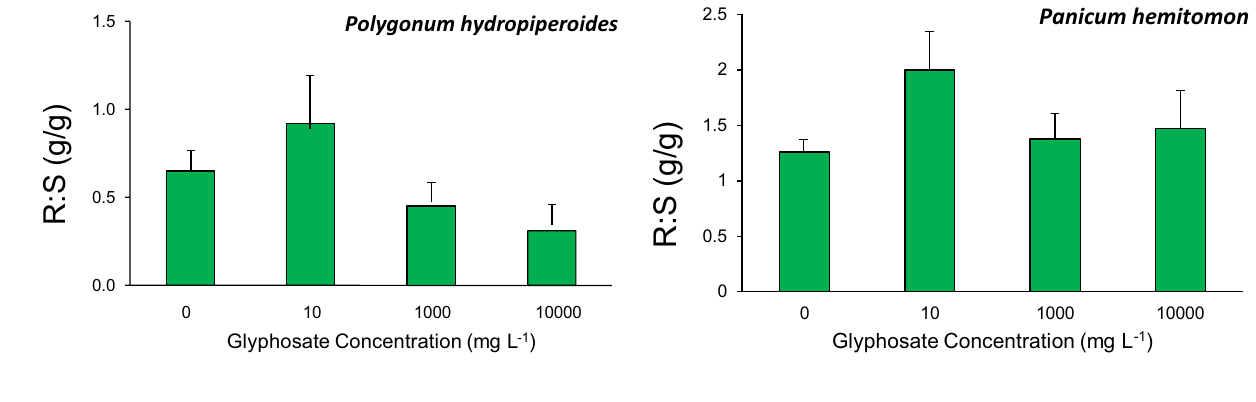
Figure 2. Root-to-shoot biomass ratios (R:S, g/g) for Polygonum hydropiperoides and Panicum hemitomon . Bars represent treatment means ± SE for 10 and six replicates for P. hydropiperoides and P. hemitomon ,